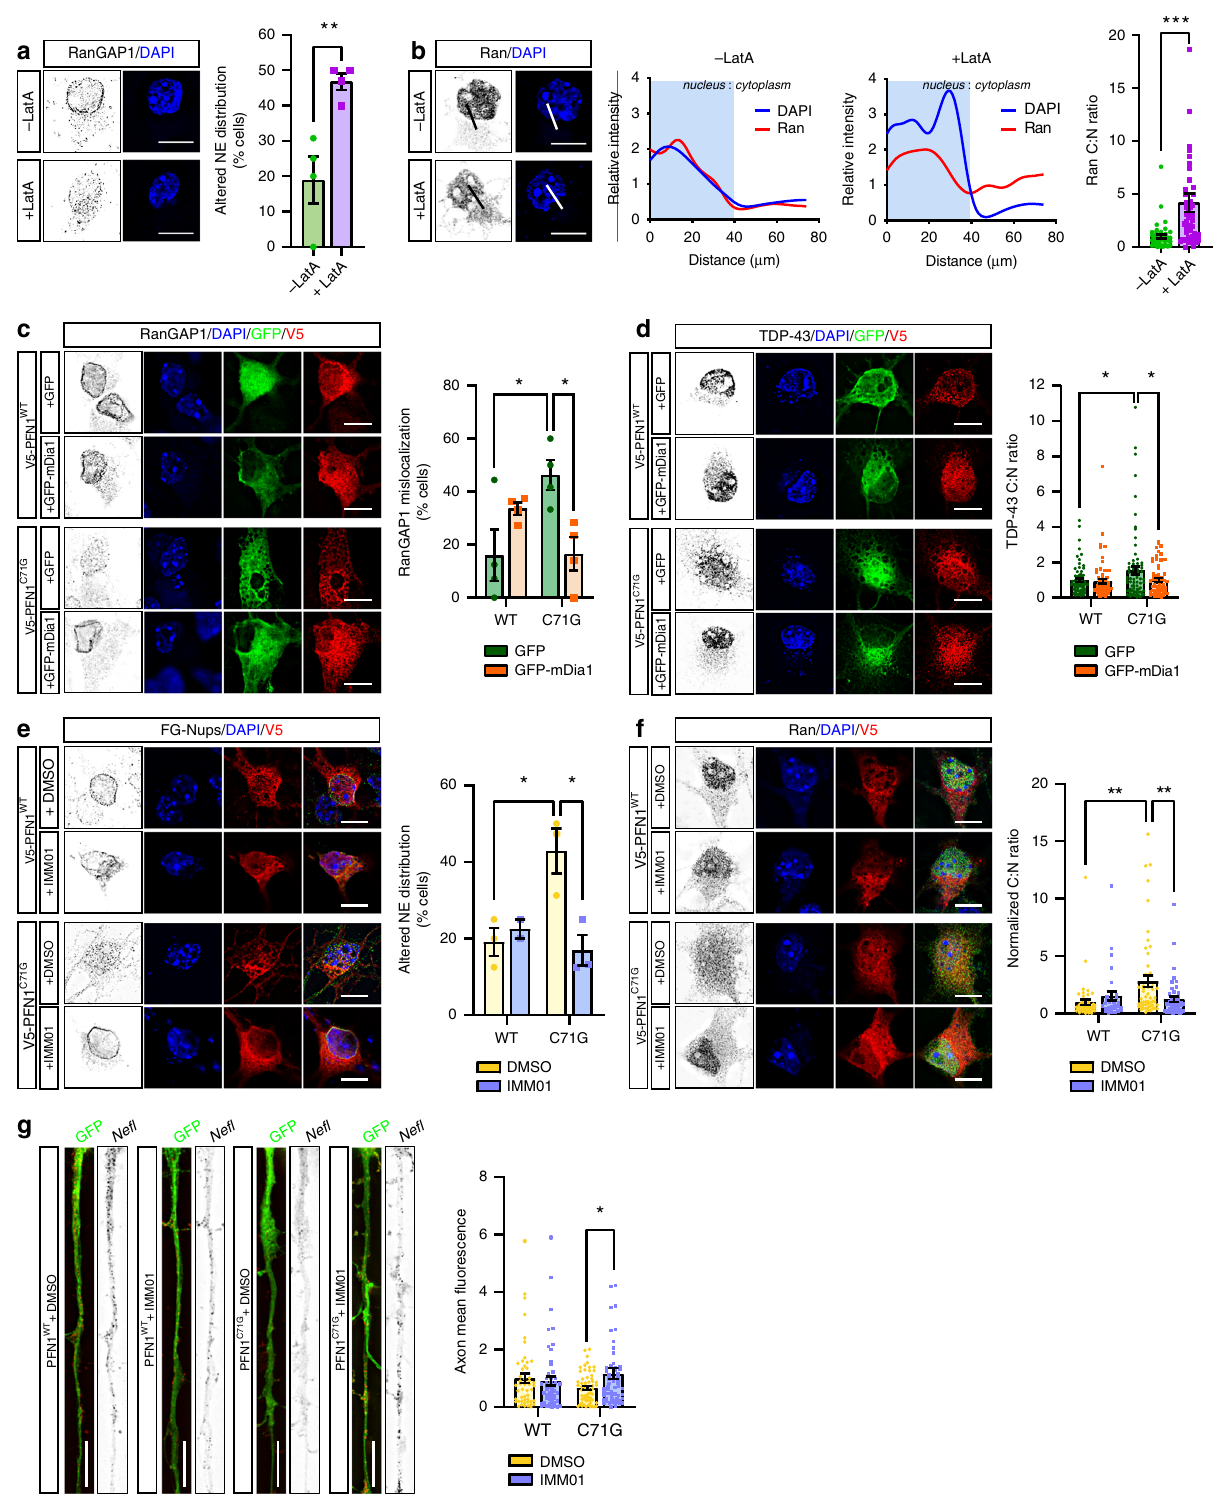
Fig. 7 Actin homeostasis is a signi fi cant modulator of NPC structure and function. a , b RanGAP1 ( a ) and Ran ( b ) localization is disrupted by Latrunculin A (LatA) treatment. Line plots of Ran and DAPI intensity are shown. c , d Representative images and quanti fi cation show rescue of RanGAP1 ( c , black) and TDP-43 ( d , black) mislocalization due to the overexpression of GFP-mDia1 (green) in MNs expressing PFN1 C71G (red). e – g Representative images and quanti fi cation show rescue of FG-Nups ( e , black), Ran ( f , black), and Ne fl mRNA ( g , black) mislocalization following treatment with IMM01 compared to DMSO alone in MNs expressing PFN1 C71G . Scale bars: 10 µ m. Bars are mean ± SEM. * p < 0.05, ** p < 0.01, *** p < 0.001. N = 4 independent experiments ( a , c ), 45 – 50 cells from 4 independent experiments ( b ), 61 – 76 cells from 5 independent experiments ( d ), 3 independent experiments ( e ), 31 – 52 cells from 3 independent experiments ( f ), 53 – 60 cells from 4 independent experiments ( g ). See also Supplementary Figs. 11 and 12 and Supplementary Table 1 for details on